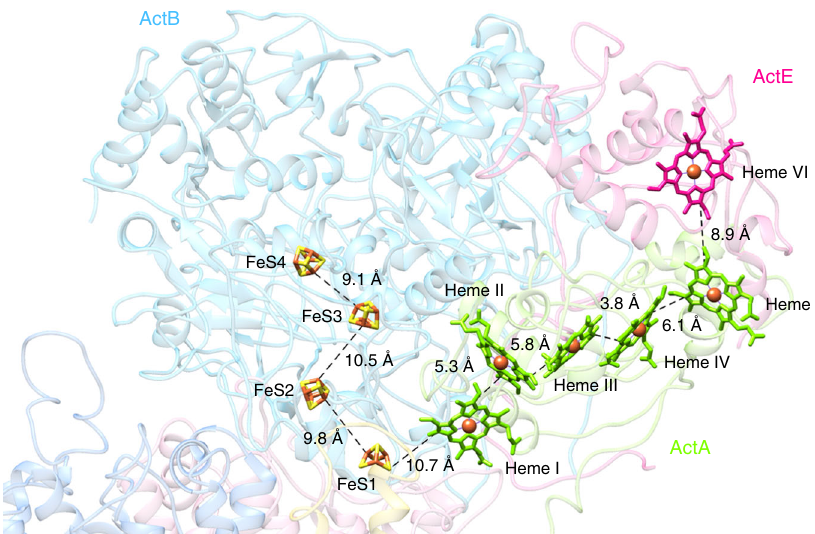
Fig. 4 Arrangement of prosthetic groups in ACIII. A ~35 Å wire of four iron – sulfur clusters and a ~60 Å six-heme wire form a branched electron transfer chain, with FeS1 receiving electrons directly from the quinol. Broken lines indicate edge-to-edge distances. ActH was removed for clarity. Subunits colored as in Fig.